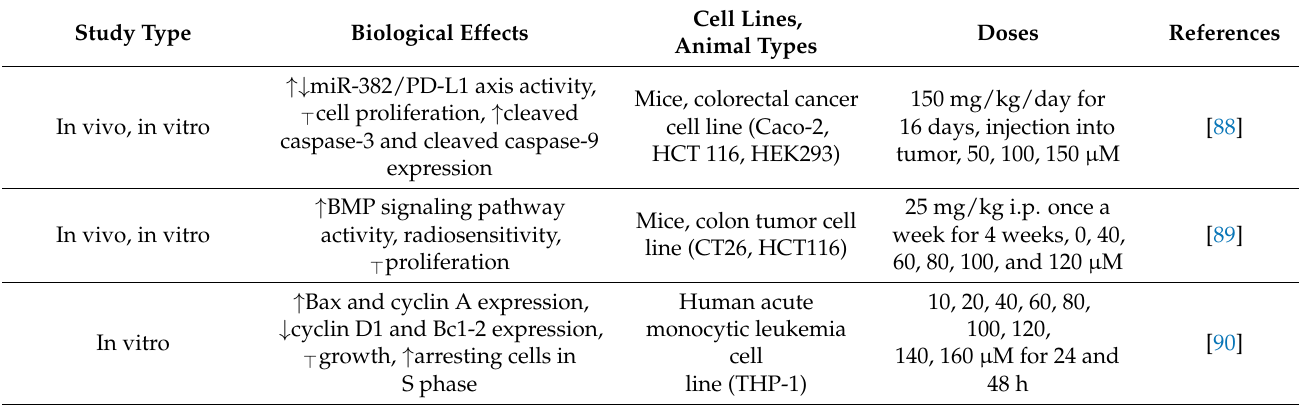
Table 1. Anticancer effects of